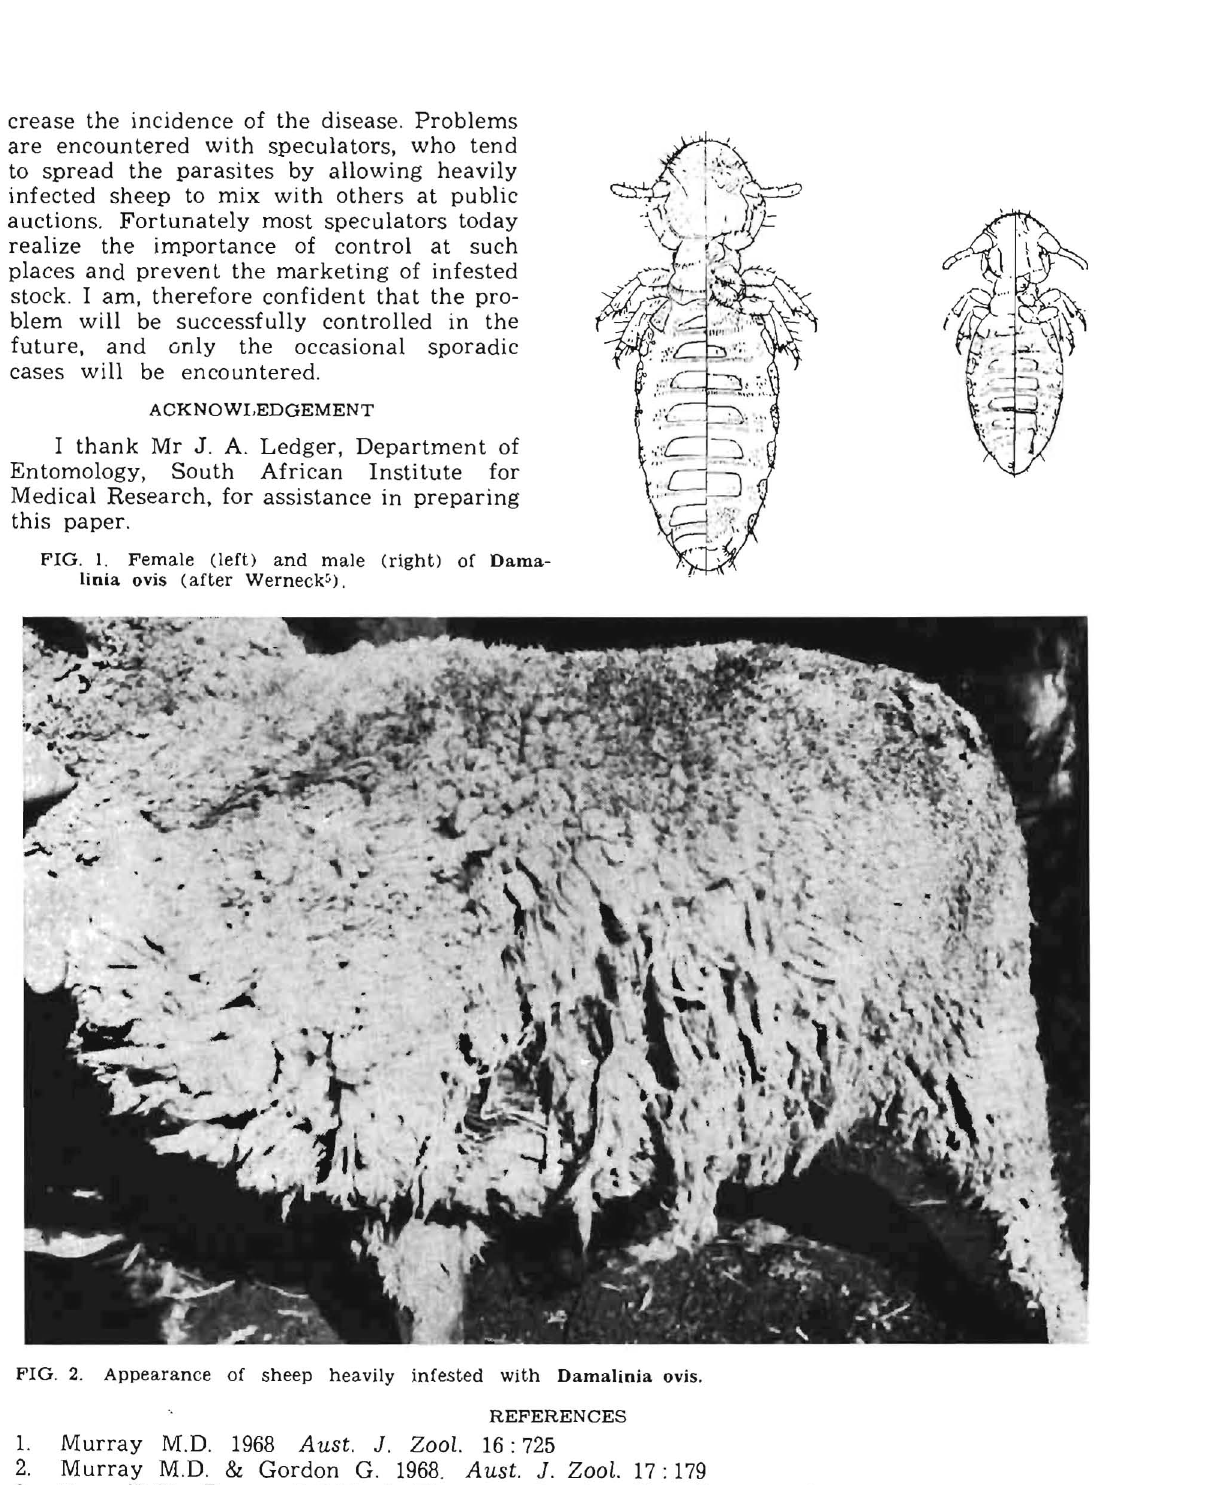
FIG. 2. Appearance of sheep heavily infested with Damalinia